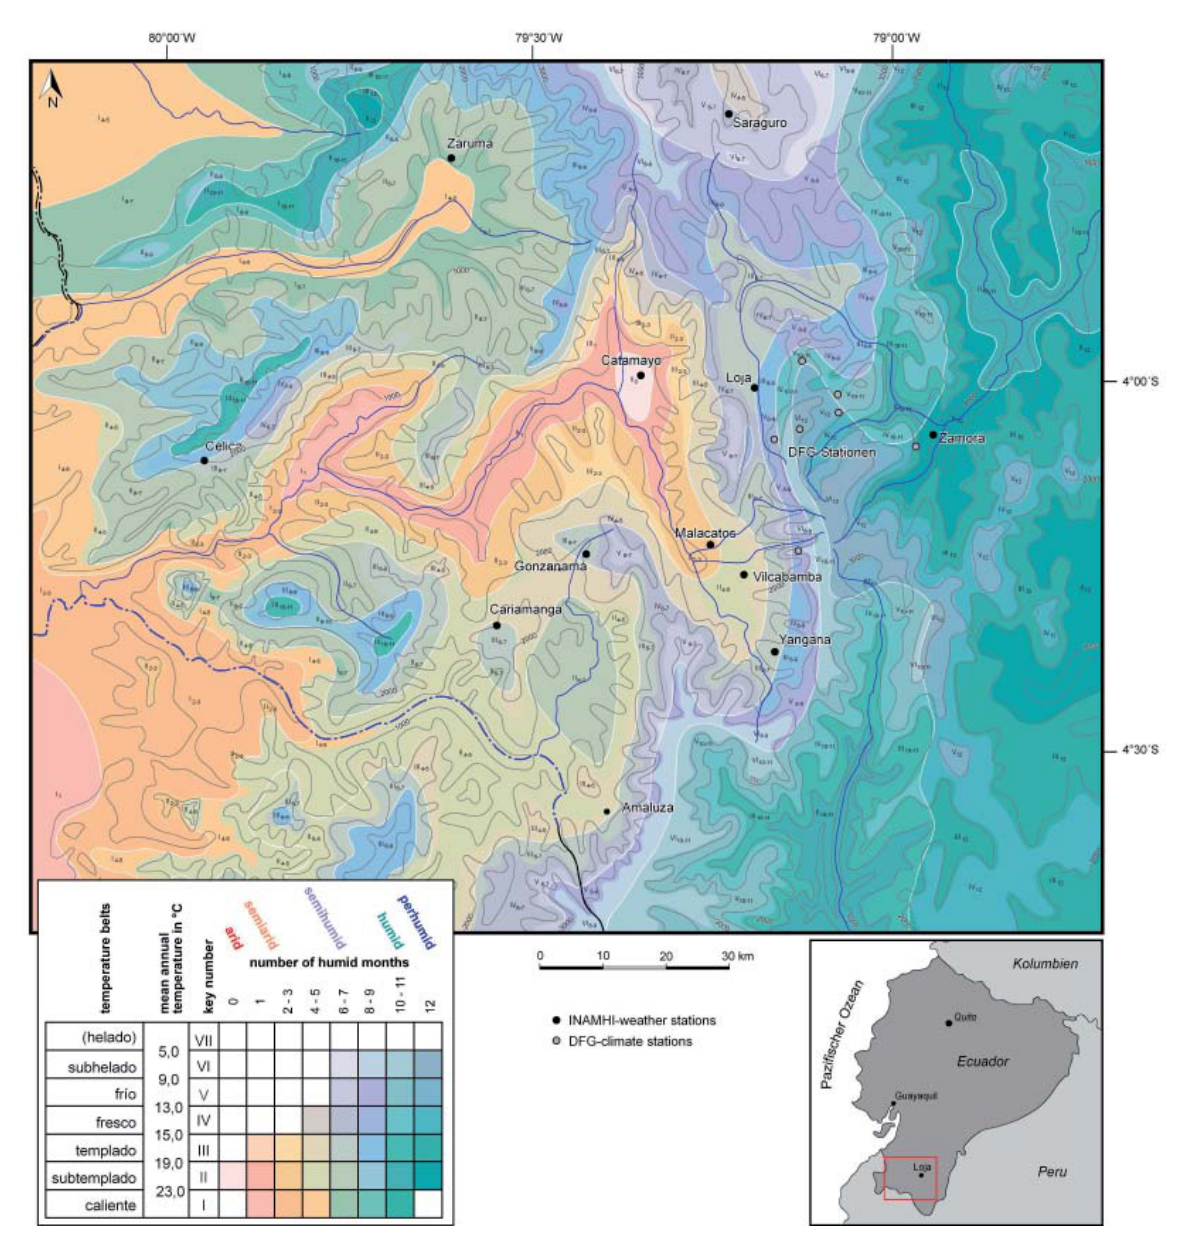
Figure 11: Hygro-thermal climate differentiation of southern Ecuador (source: M. Richter